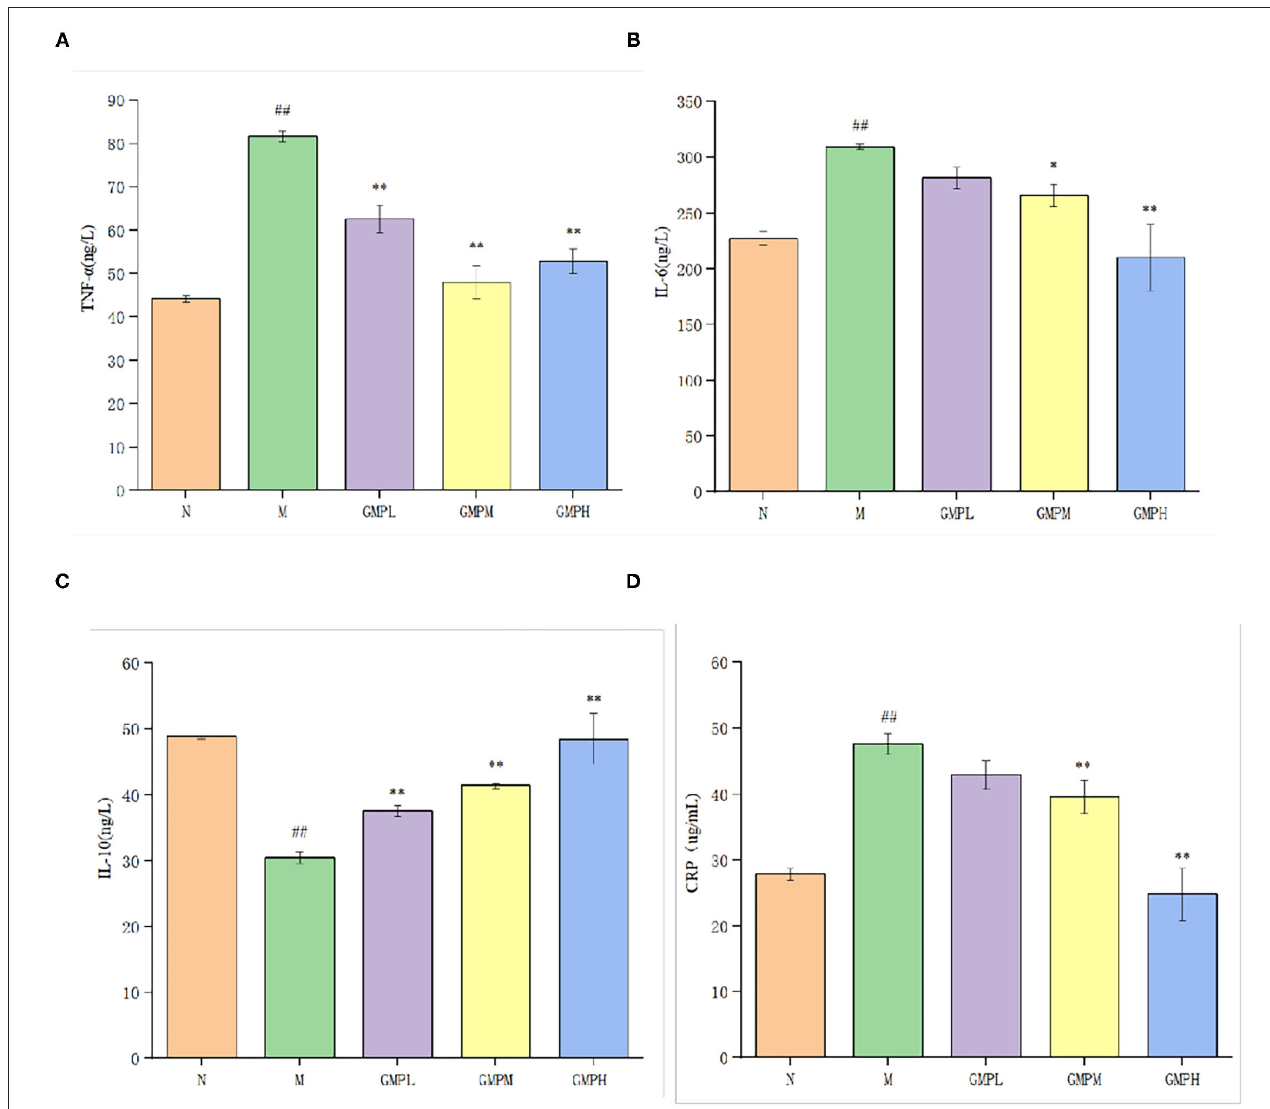
FIGURE 5 | Effects of different doses of GMP on serum inflammatory factors in mice. (A) Serum TNF- α level. (B) Serum IL-6 level. (C) Serum IL-10 level. (D) Serum CRP level. The data in the figure are expressed as mean ± SD ( n = 6). Significance of difference: *means p < 0.05, **means p < 0.001, compared with group M. ## means p < 0.001, compared with group N. GMP, germinated mung bean polyphenol; IL, interleukin, TNF- α , tumor necrosis factor- α